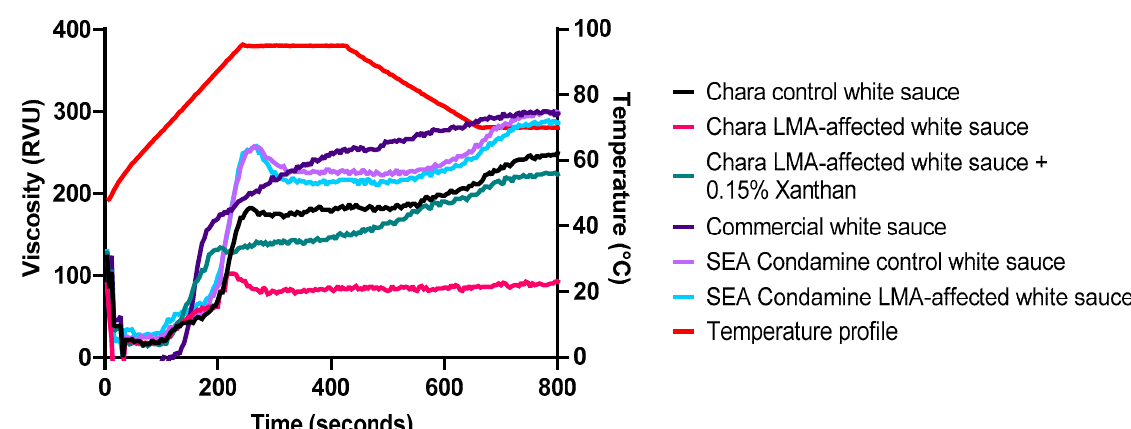
Figure 4. Gelation behaviour of white sauces prepared from control and LMA-affected flour during thermal processing.